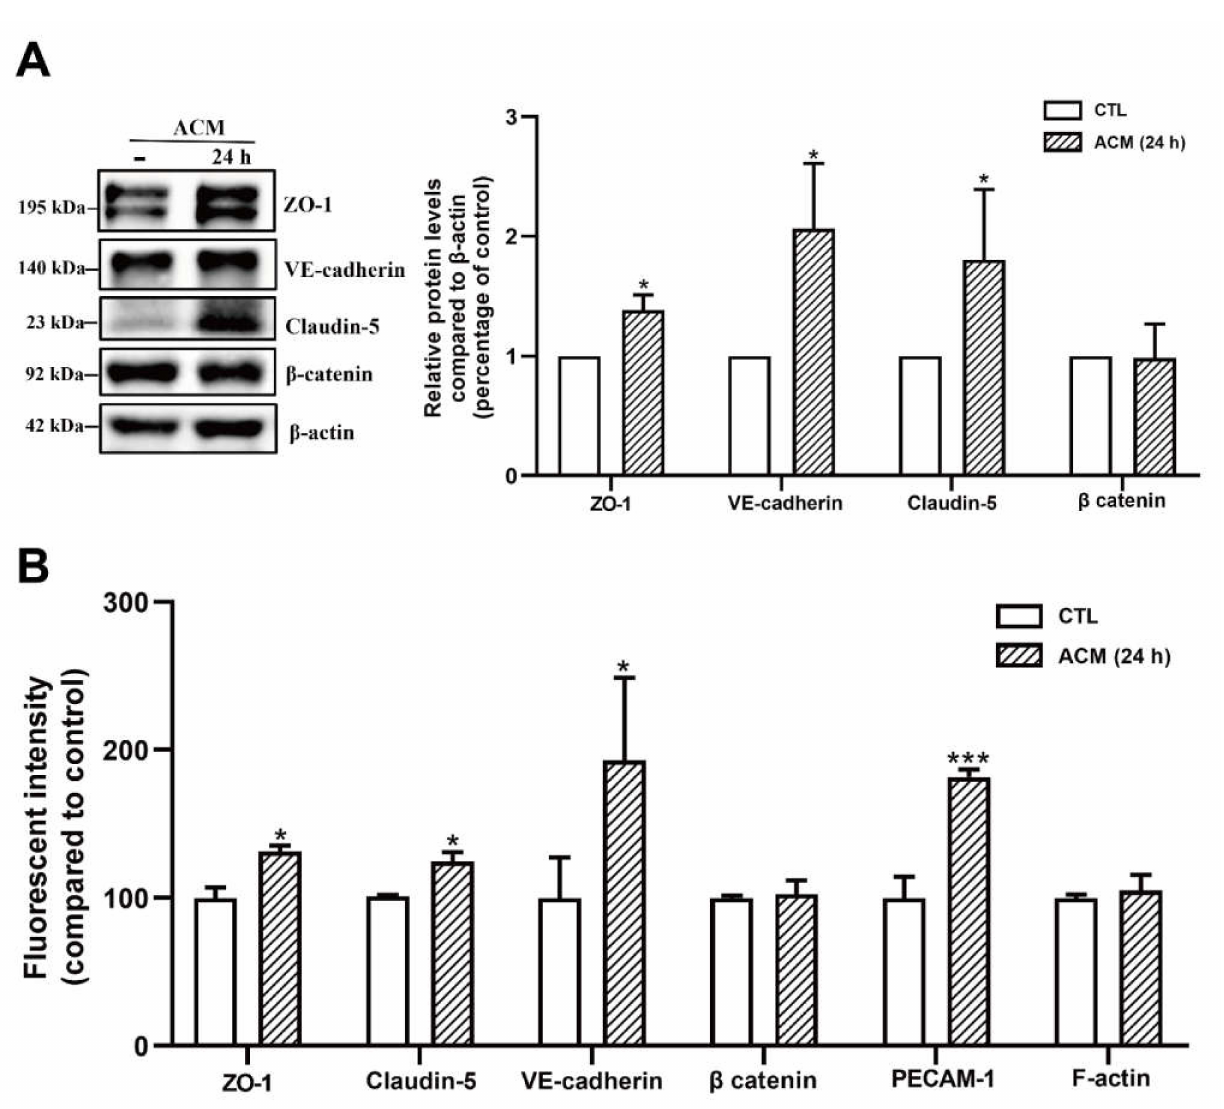
Figure 5. C8-D1A co-culture or astrocyte-conditioned medium (ACM) upregulated the levels of junctional proteins in bEnd.3 cells. ( A ) The protein expression level of junctional proteins ZO-1, VE-cadherin, claudin-5, and β -catenin. ( B ) Fluorescent intensity of junctional proteins ZO-1, claudin-5 and VE cadherin, β catenin, PECAM-1, and cytoskeleton protein F-actin after the treatment of ACM (24 h) for 24 h. Data are shown as means ± SD of at least three independent experiments and were analyzed by one-way ANOVA followed by a post hoc Dunnett’s test. * p ≤ 0.1, *** p ≤ 0.001 vs. control